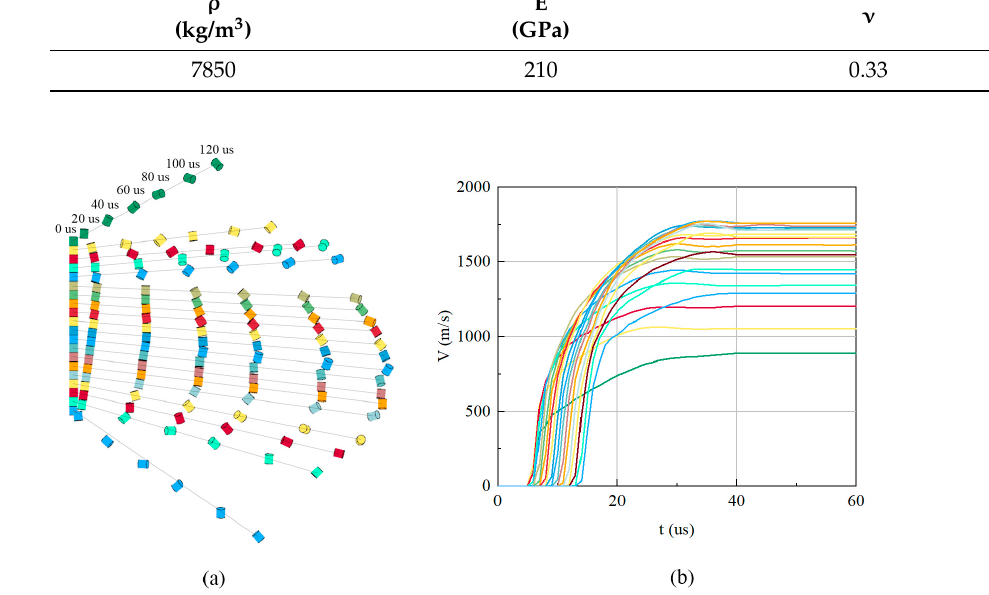
Figure 2. Simulation results: ( a ) Projection distribution of the fragments along the axial at t = 0 us, 20 us, 40 us, 60 us, 80 us, 100 us and 120 us. ( b ) Velocity curves of the fragments in ( a ) with color correspondence.